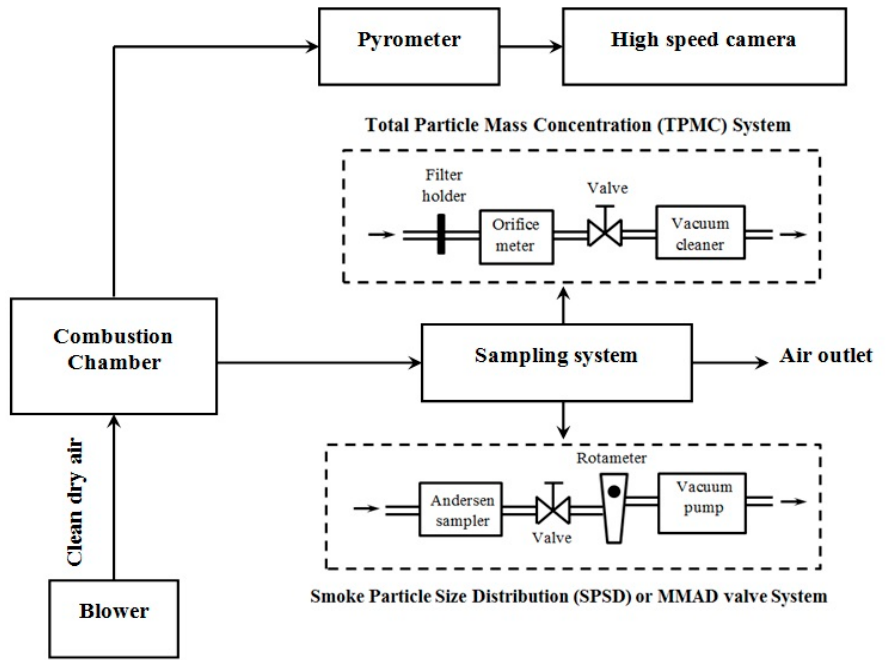
Figure 2. Schematic of the experimental